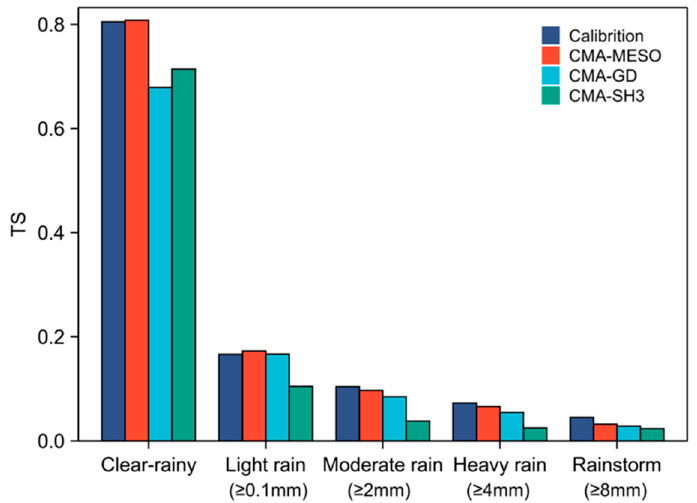
Figure 9. TS of multi-model forecast (CMA-MESO, CMA-GD, and CMA-SH3) and calibrated forecast (dark blue) initiated at 00:00 UTC on 11 August 2020.